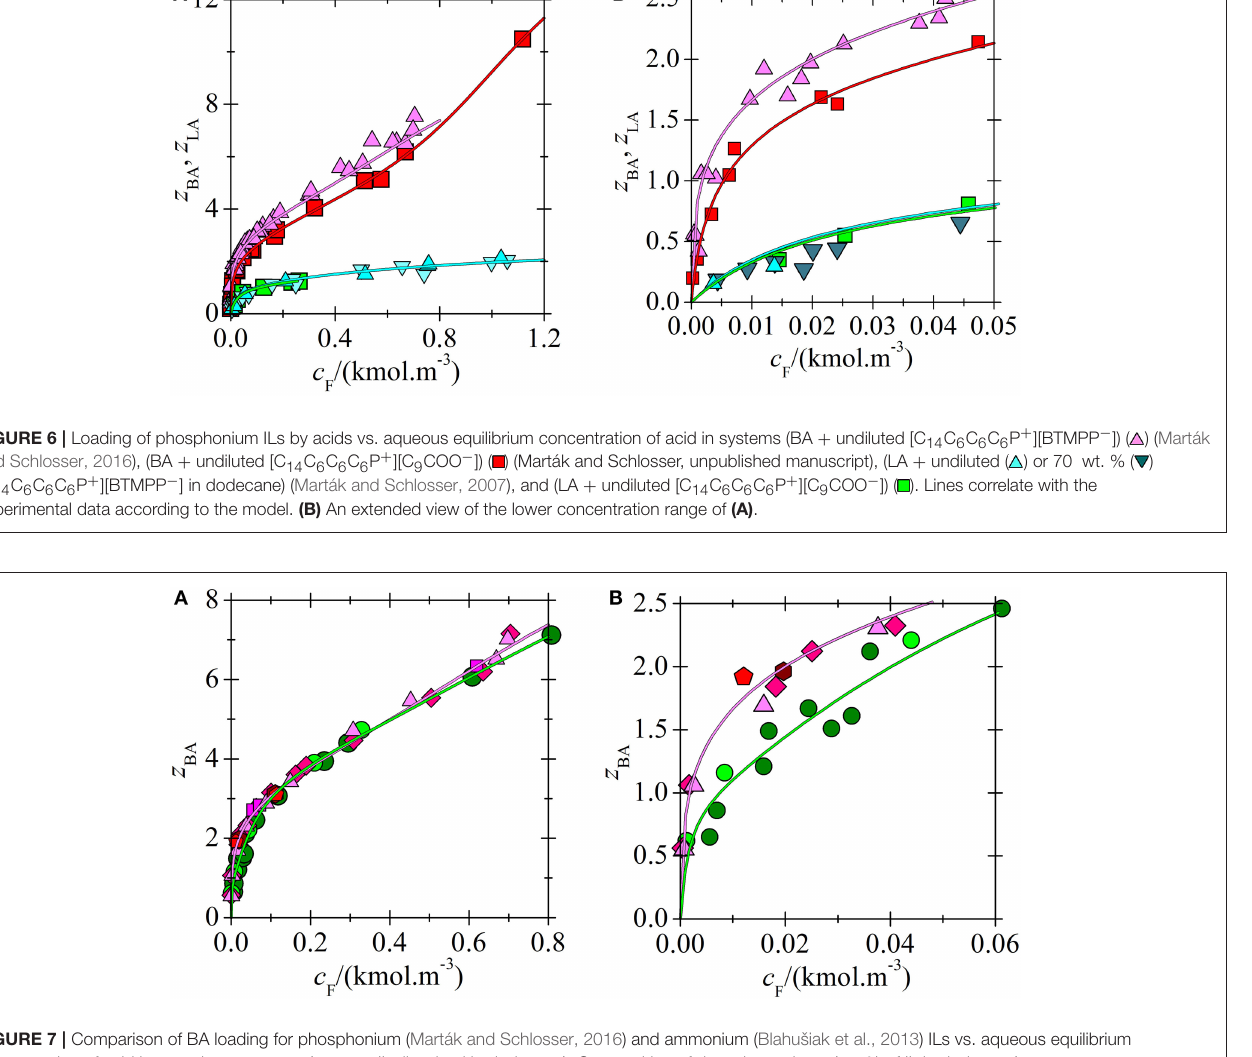
FIGURE 7 | Comparison of BA loading for phosphonium (Marták and Schlosser, 2016) and ammonium (Blahušiak et al., 2013) ILs vs. aqueous equilibrium concentration of acid in two-phase systems (water + IL dissolved in dodecane). Composition of dry solvent phase (wt. % of IL in